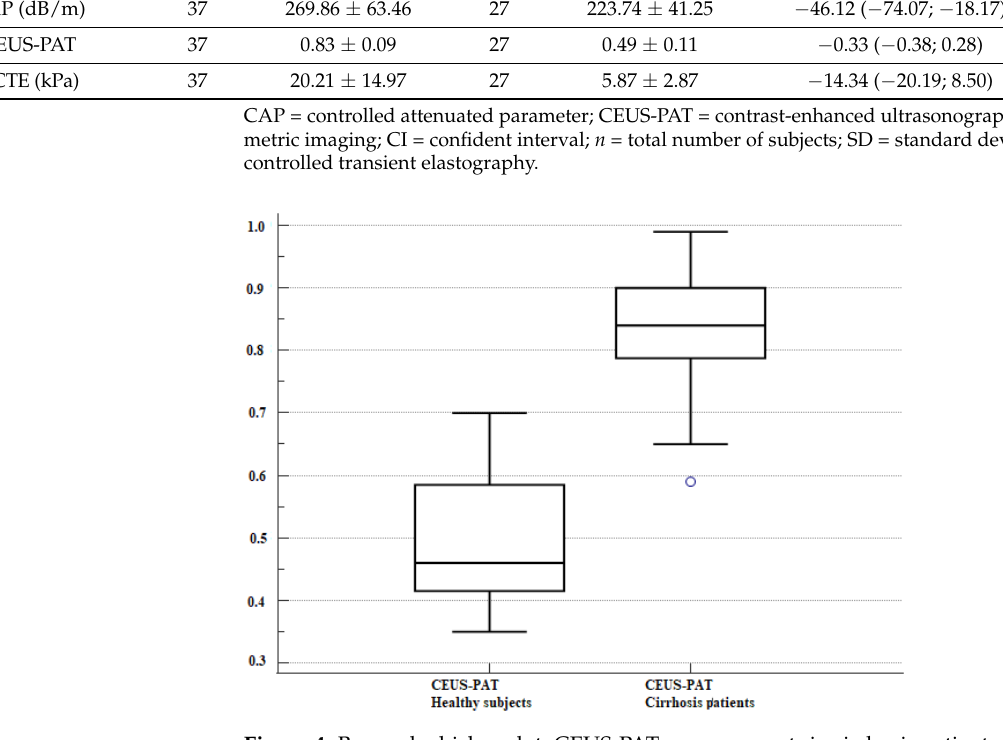
Figure 4. Box and whisker plot. CEUS-PAT measurements in cirrhosis patients and healthy volunteers. The boxes are proportional to the inter-quartile range (IQR) with medians marked in-between, and the whiskers are proportional to 1.5 * IQR (or trimmed to the minimum or maximum values). The bullet is an outlier.